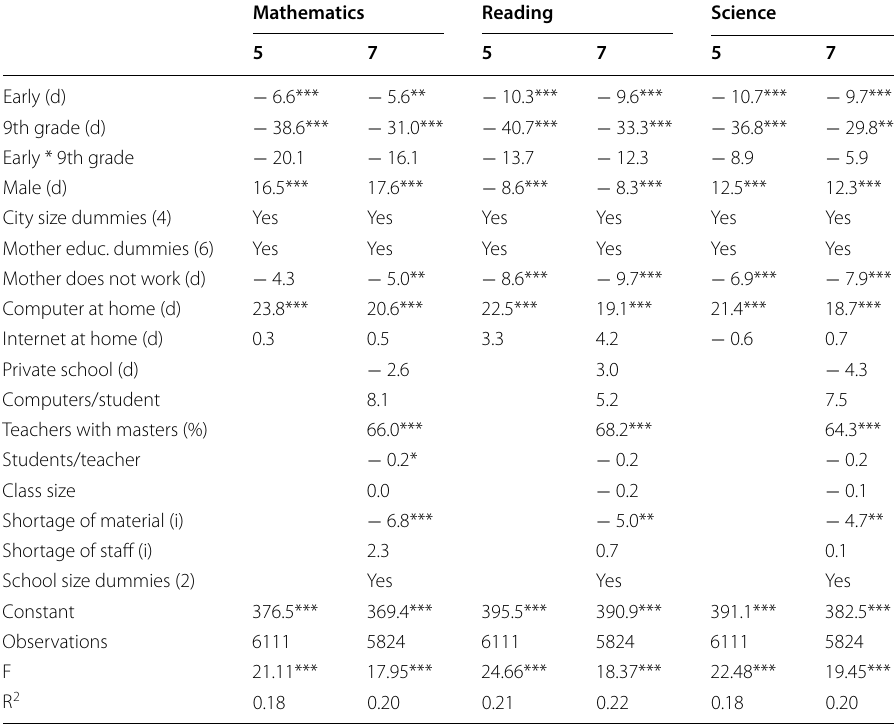
Table 6 Early entrance and PISA Scores (Plausible Values) Source: Own estimation with data from PISA 2018,